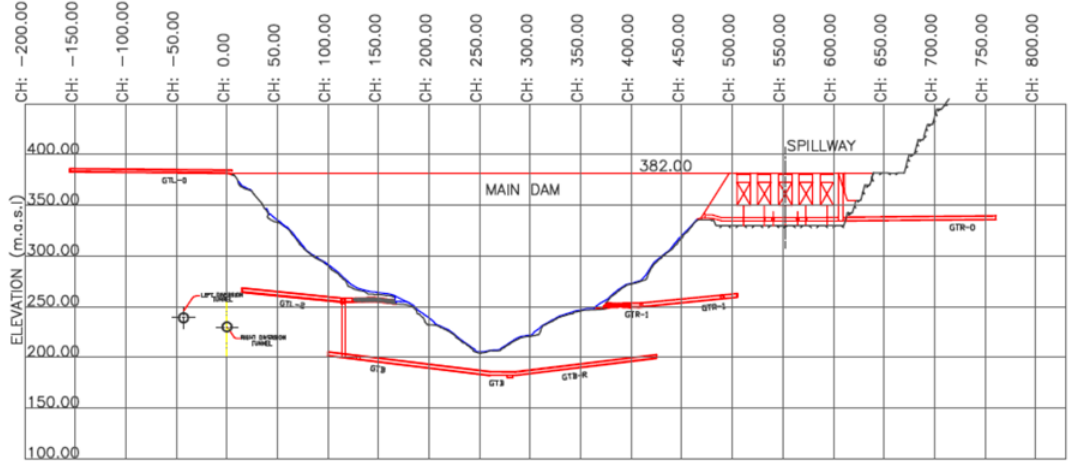
Fig. 8. Longitudinal section of Masjed Soleiman Dam